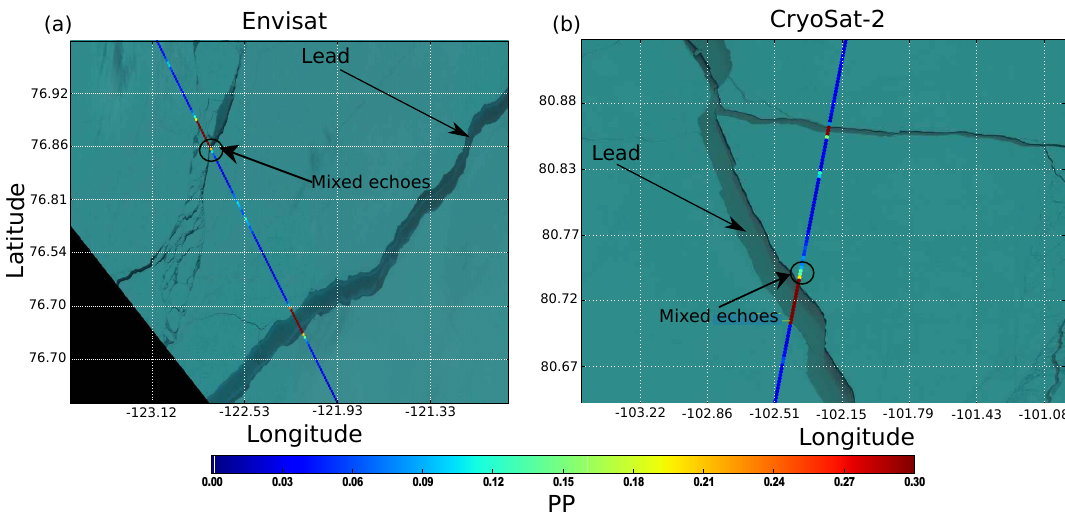
Figure 1. (a) PP spatial variability along the Envisat track (16 April 2003) plotted over a Landsat-7 LandsatLook Image acquired on the same day and (b) PP spatial variability along CryoSat-2 track (1 May 2015) plotted over a Landsat-8 LandsatLook Image also acquired on the same day. For both figures, each dot represents a 20Hz PP